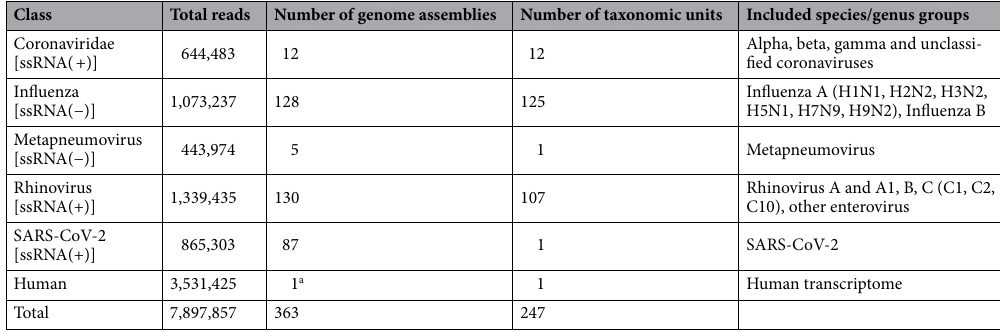
Table 3. Summary of training classes used for PACIFIC. a GENCODE canonical transcripts were used to represent human reads in RNA-seq